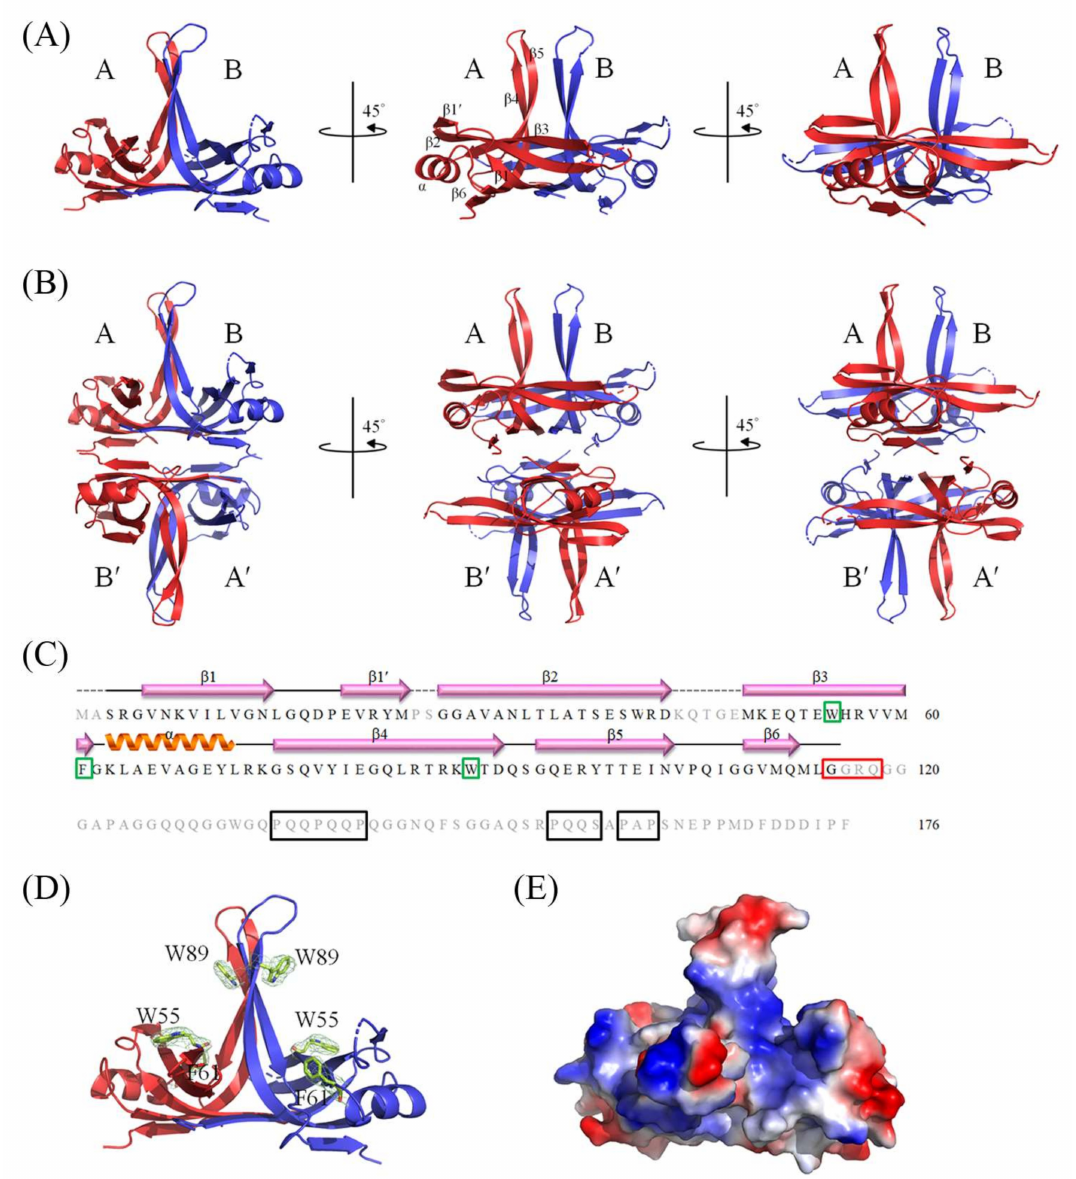
Figure 1. An SSB protein from S. enterica serovar Typhimurium LT2. ( A ) Crystal structure of SeSSB. Two monomers of the SeSSB were found per asymmetric unit. The core of the OB-fold in the SeSSB is made of a six-stranded β -barrel capped by an α -helix. The C-terminal region (residues 116–176)